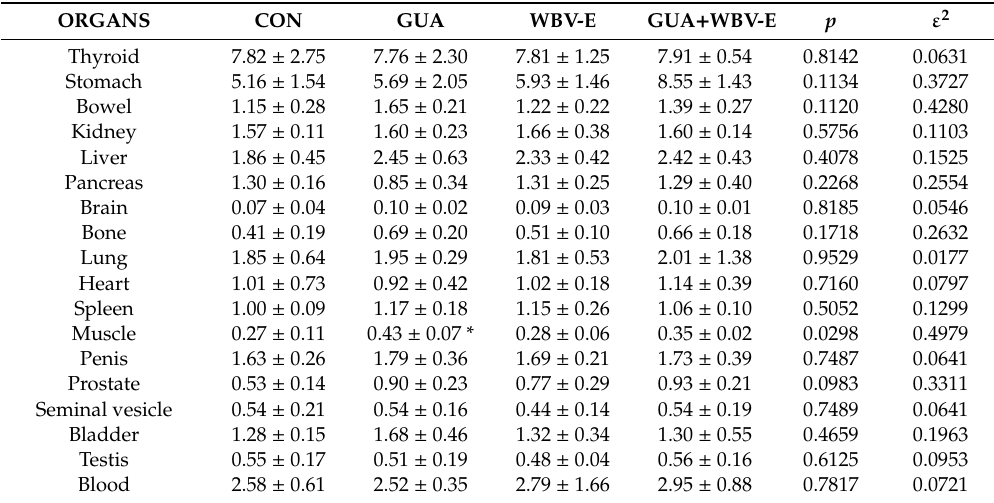
Table 1. %ATI / g of the Na 99m TcO 4 from organs isolated from the rats submitted to some interventions. ORGANS